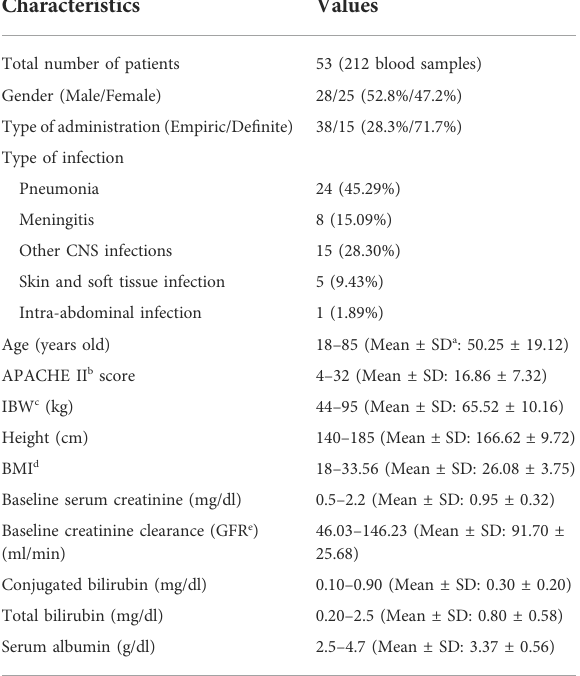
TABLE 1 Patients ’ demographic characteristics and laboratory data.